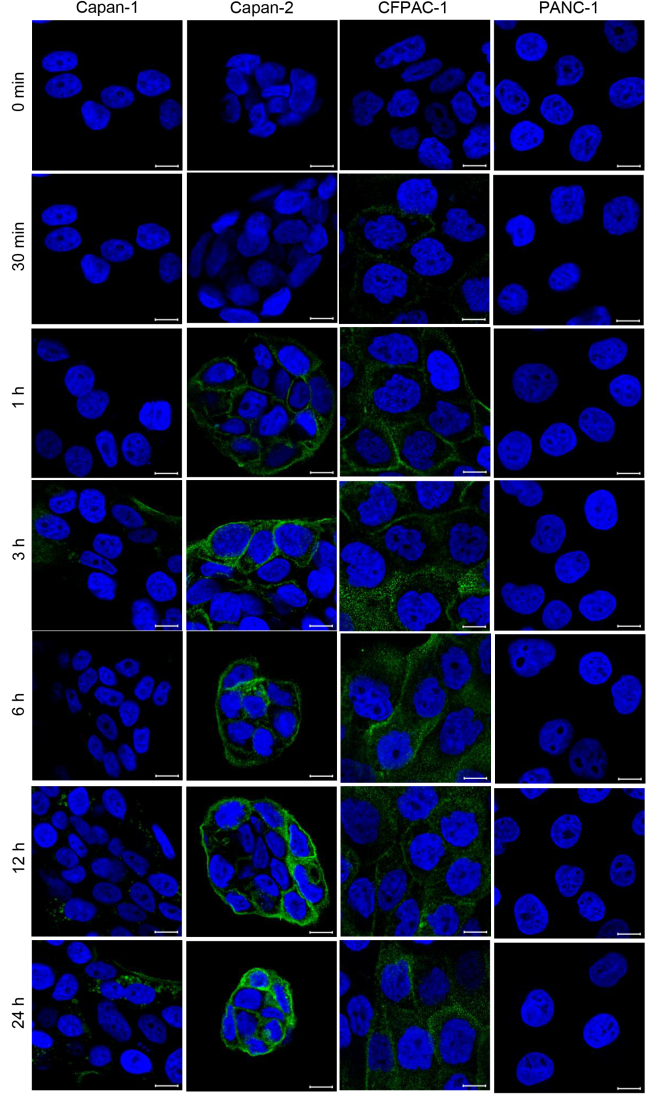
Figure 2. Time-dependent internalization of anti-hMUC1 monoclonal antibody into pancreatic cancer cells. Capan-1, Capan-2, CFPAC-1 and PANC-1 cells were incubated with DyLight 488-conjugated anti-hMUC1 monoclonal antibody for various time intervals and analyzed by confocal microscopy. Hoechst 33258 was used for staining nuclei. Scale bars, 10 µ m. These results are representatives of three independent experiments.